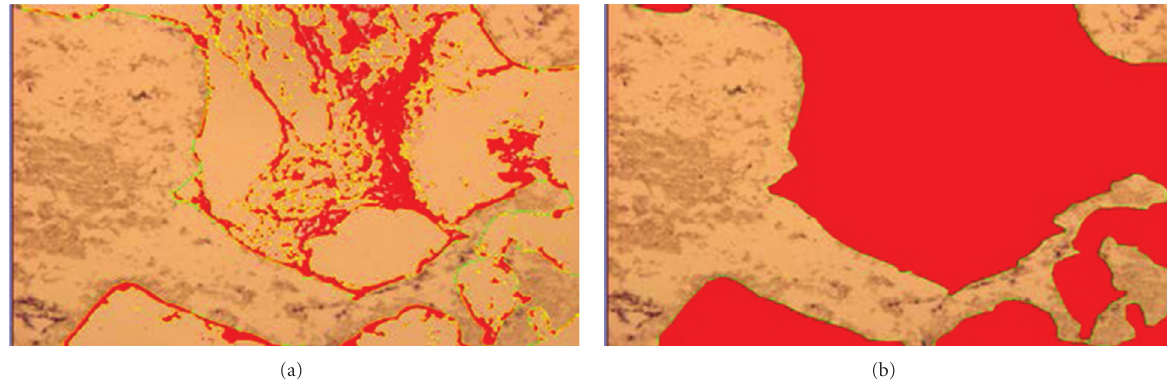
Figure 3: 40x magnification. To determine cell/matrix area coverage, a ratio was calculated between (a) area of cell/matrix coverage and (b) total area of pore spaces. The area in red was used for measurement and was determined by setting a threshold value in Bioquant.